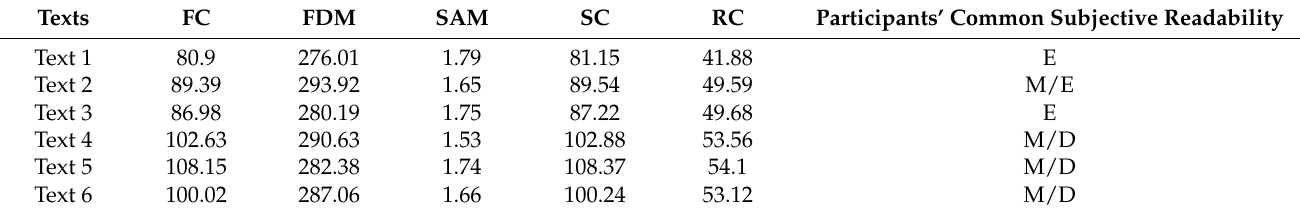
Table 8. Texts’ aggregated eye-tracking measures and common subjective readabilities assigned by